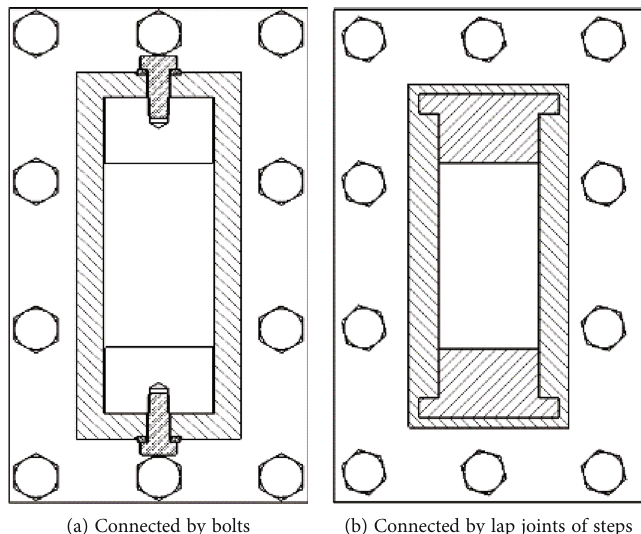
Figure 4: The chamber shell and the internal pro fi le connection mode.